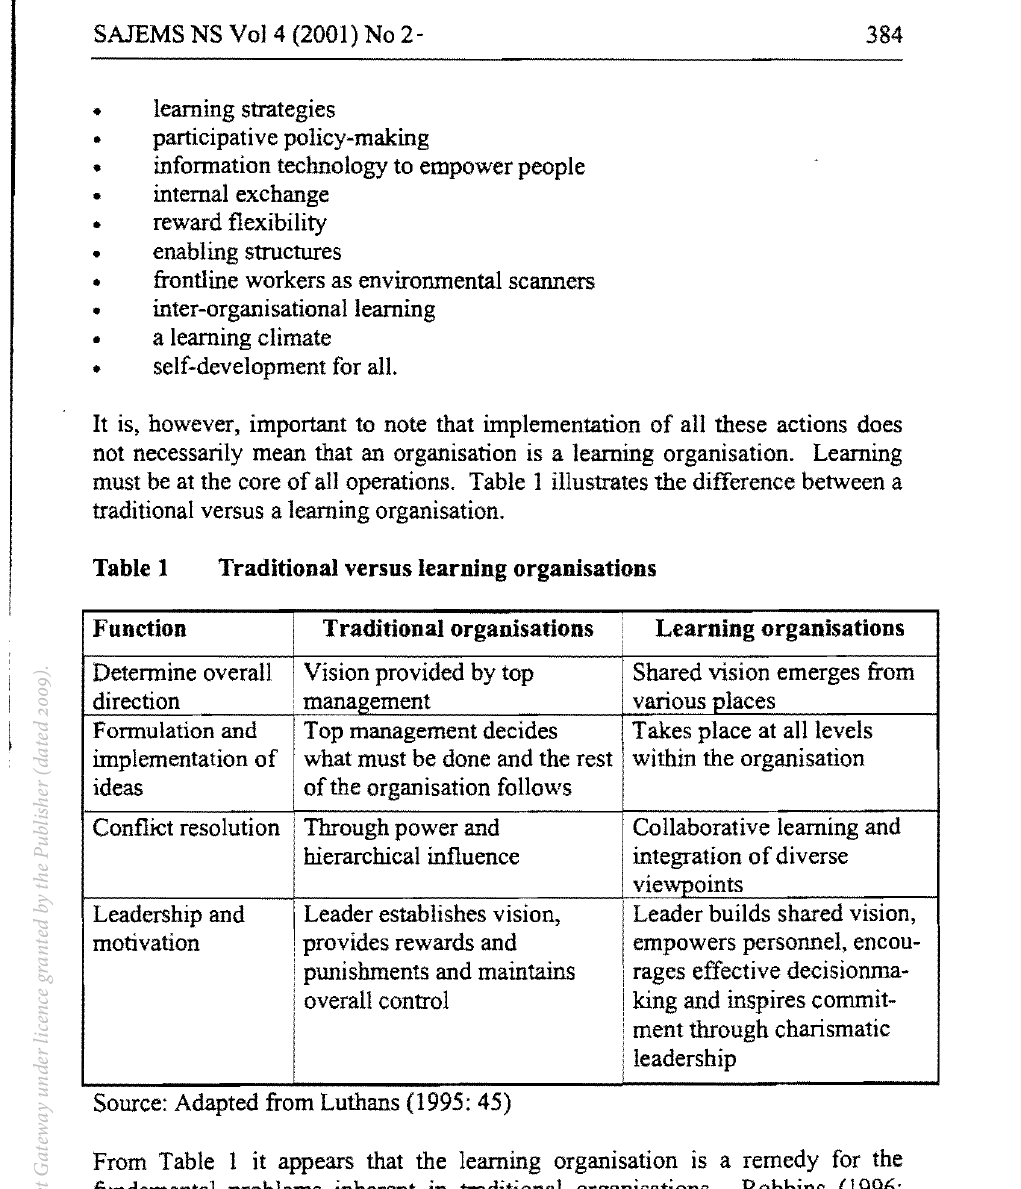
Traditional versus learning organisations Function Traditional organisations Learning organisations Detennine overall Vision provided by top Shared vision emerges from direction ! management various places Fonnulation and Top management decides Takes place at all levels implementation of what must be done and the rest within the